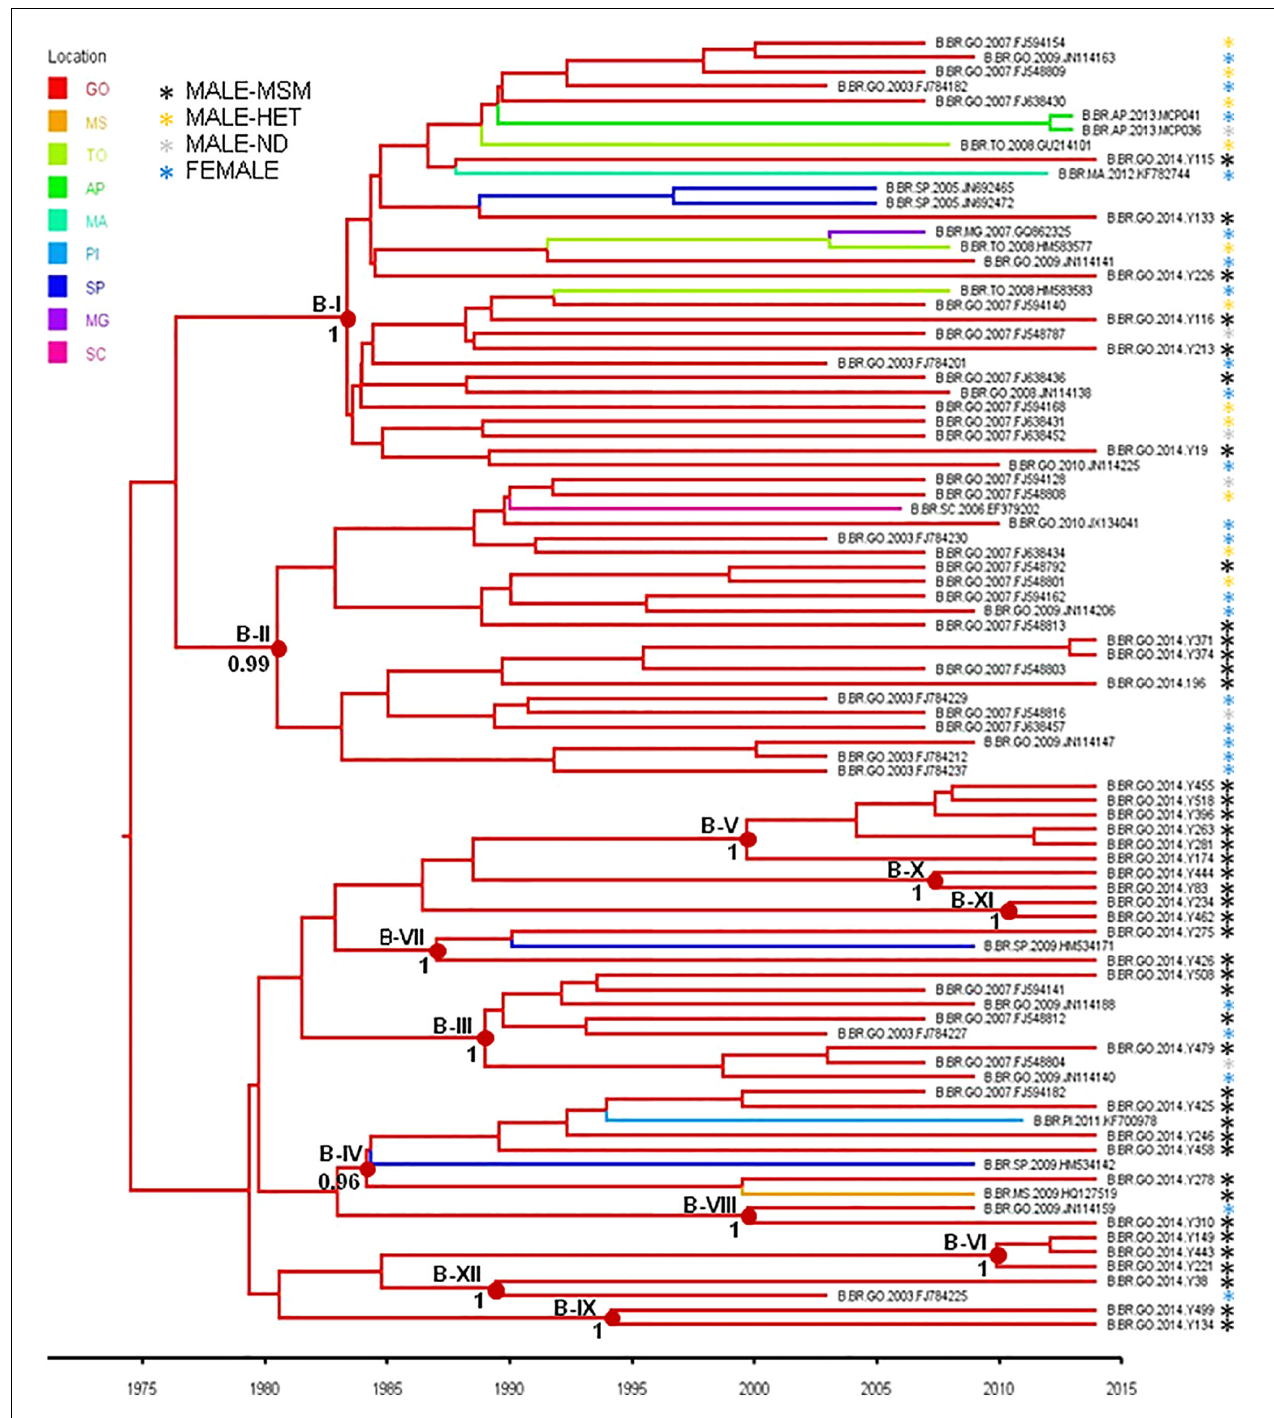
FIGURE 4 | Time-scaled Bayesian Markov Chain Monte Carlo (MCMC) tree of HIV-1-subtype B pol sequences from the 12 transmission clusters among MSM from Central-Western Brazil. Branches are colored according to the most probable location state of their descendent nodes as indicated in the legend at the upper left side. Sequences are marked with an asterisk colored according to the risk group. Internal circles indicate the positions of the ancestral nodes of each subtype B cluster. Numbers at ancestral nodes indicate the clade support ( PP ) of subtype B transmission cluster. Branch lengths are depicted in units of time (years). The tree was automatically rooted under the assumption of a relaxed molecular clock. Location states: Goiás (GO), Mato Grosso do Sul (MS), Tocantins (TO), Amapá (AP), Maranhão (MA), Piauí (PI), São Paulo (SP), Minas Gerais (MG), Santa Catarina (SC).